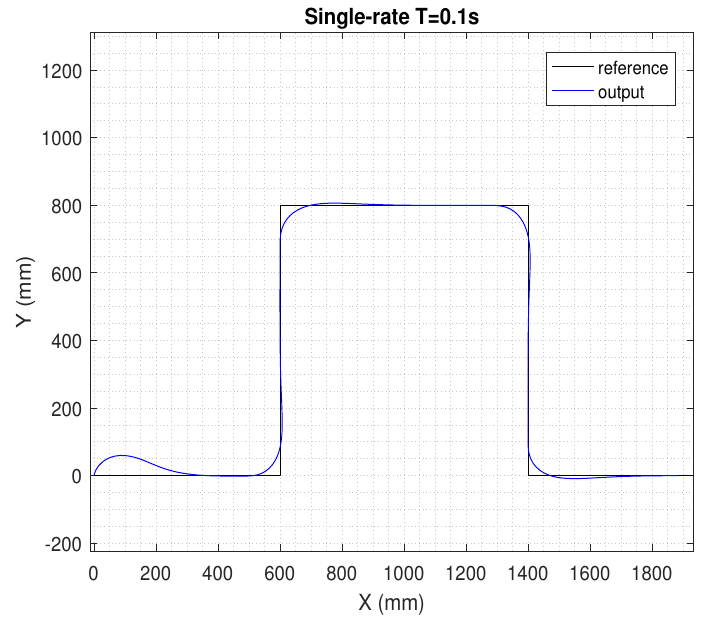
Figure 5. Results for the single-rate control at T = 0.1